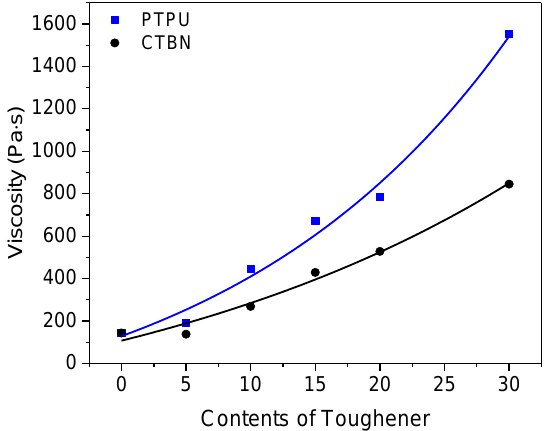
Figure 5. Change in the viscosity of the epoxy adhesives by the addition of PTPU and CTBN.